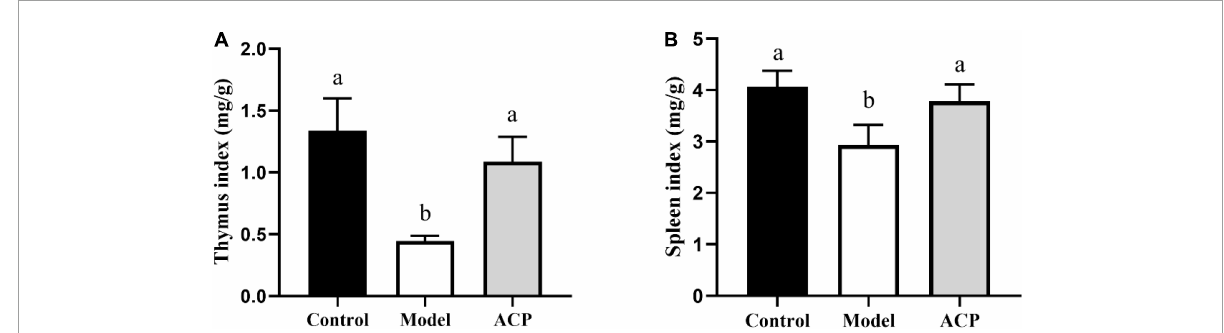
FIGURE1 Effect of Auricularia cornea var. Li. polysaccharides (ACP) supplementation on immune organ indices in immunosuppressed mice. (A) Thymus index and (B) spleen index. Values are mean ± SD ( n = 6 independent experiment). Different superscript letters indicate significant differences ( P < 0.05) by using one-way analysis of variance, followed by Duncan’s test.